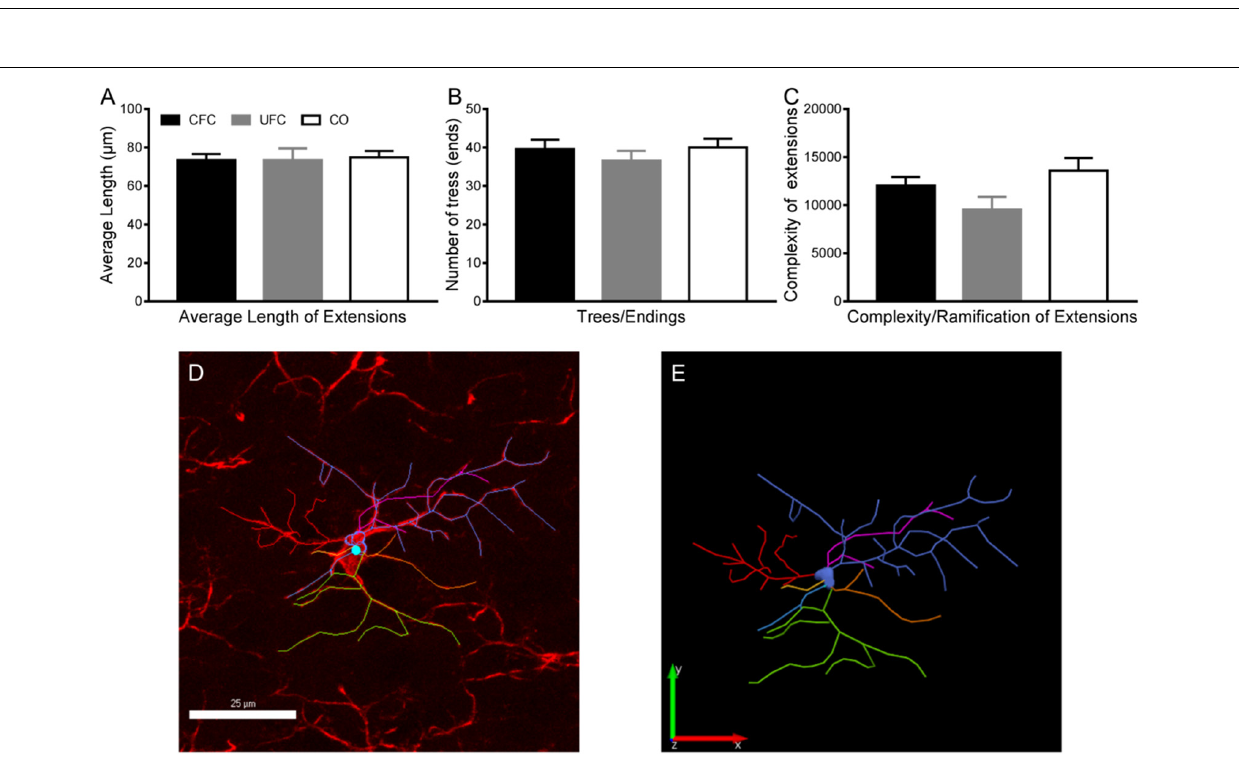
FIGURE 5 | Microglia morphology in PL layer 2–3. Evaluation of microglia morphology in PL layer 2–3 revealed no changes as a function of condition. As seen, the average length of extensions (A) , number of trees/endings (B) and complexity of ramifications (C) remained statistically similar in all three behavioural groups. (D) Representative traces microglia with tracing overlaid, and (E) the tracing alone. PL, pre-limbic cortex. Scale bar = 25 µ m.